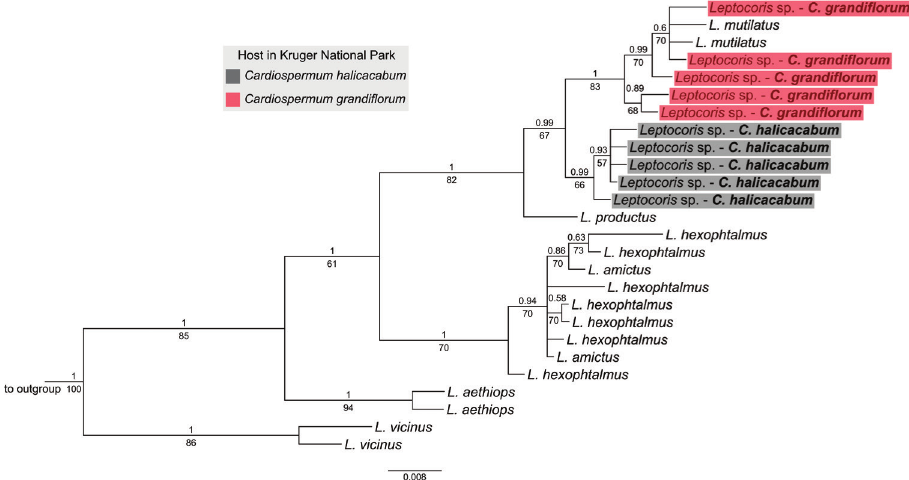
Figure 2. Bayesian phylogeny based on COI DNA sequencing data illustrating phylogenetic relation- ships among African Leptocoris species. Shaded branches refer to Leptocoris specimens collected from Car- diospermum halicacabum and C. grandiflorum in Kruger National Park. Nodal support is shown as poste- rior probabilities and bootstrap values above and below the branches,